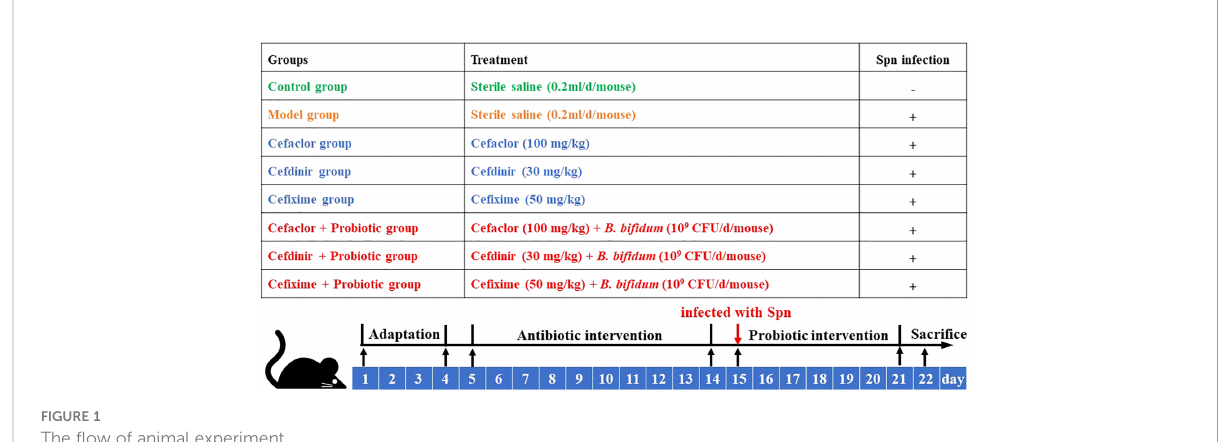
FIGURE 1 The fl ow of animal